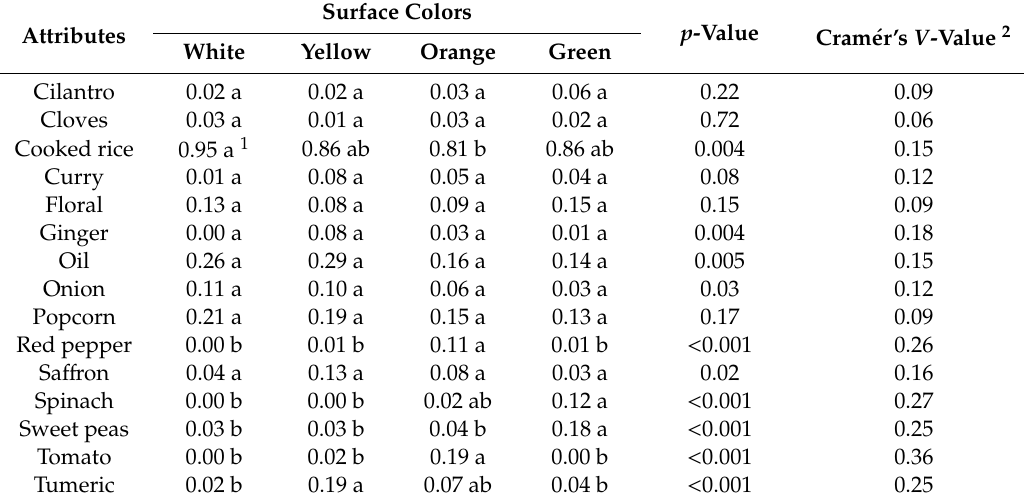
Table 1. A contingency table of the proportions of selection by 98 participants for individual sensory attributes among the four cooked-rice samples with different surface colors.